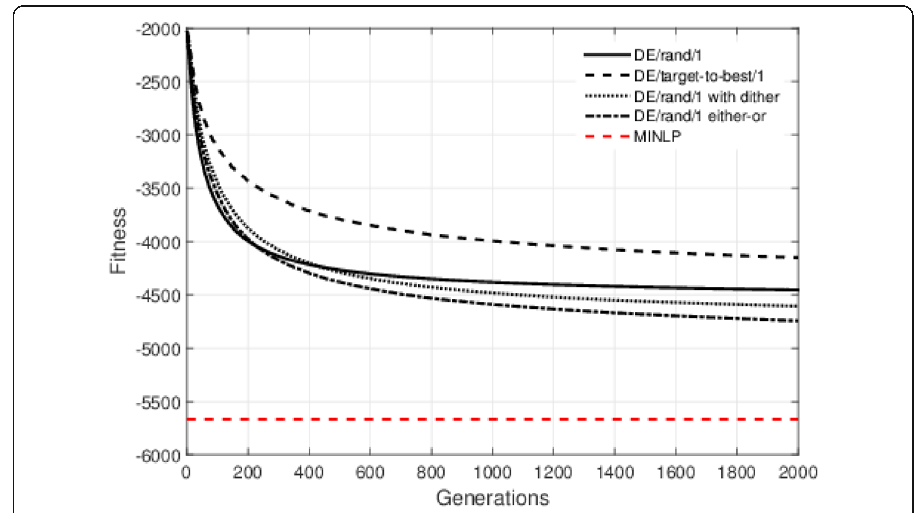
Fig. 5 Plot of algorithms ’ convergence generated with Meta-ERM